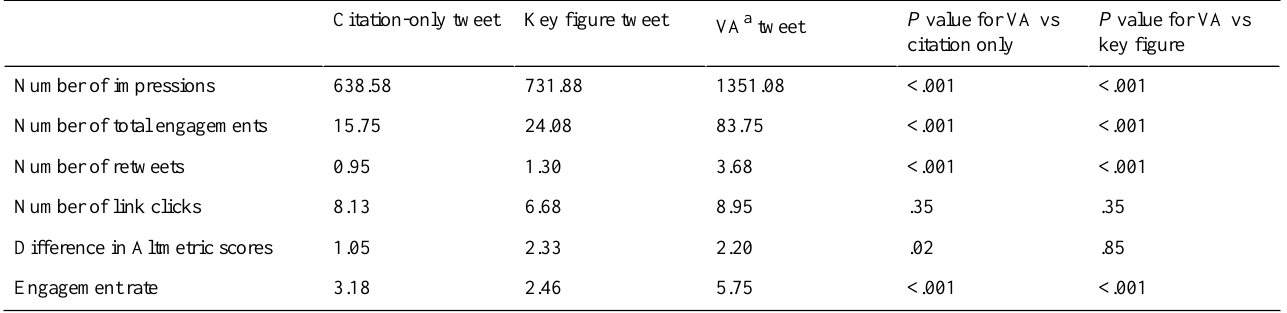
figure tweet compared to the 2 weeks following a visual abstract tweet ( P =.85). Table 1. Comparison of measures between tweet types.